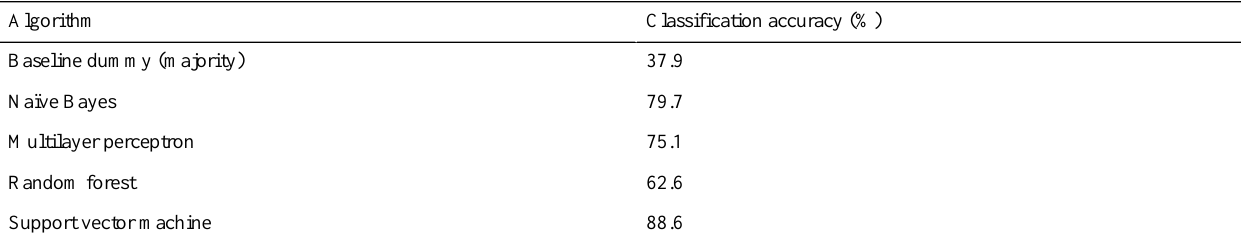
Table 3. Classification accuracies of the psychological profile